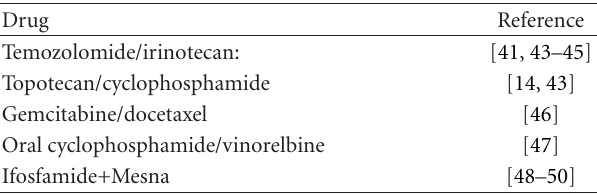
Table 4: Sarcoma chemotherapy combinations with activity in relapsed sarcomas including Ewing’s family of tumors.